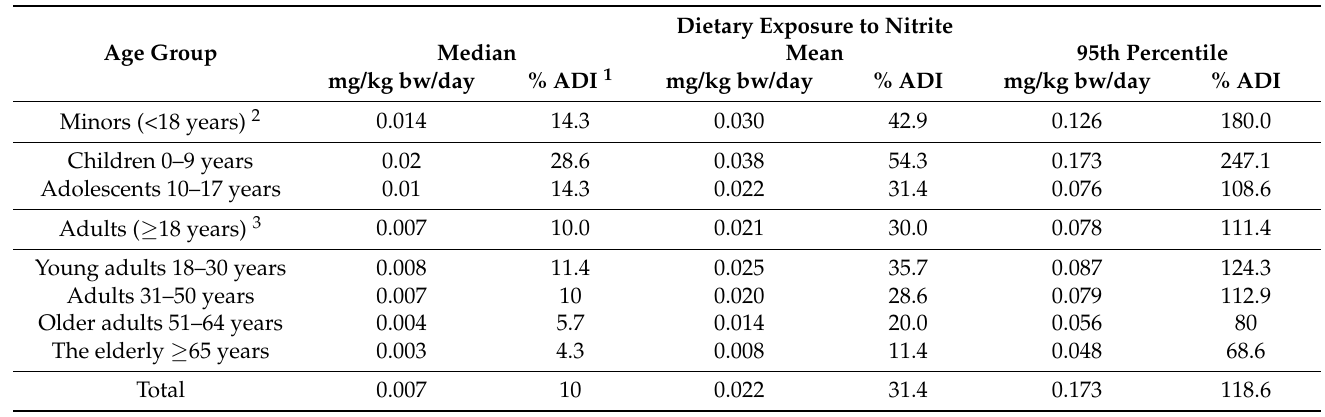
Table 1. Summary of dietary exposure to nitrite from processed meat products (in mg/kg bw/day and as % of ADI).